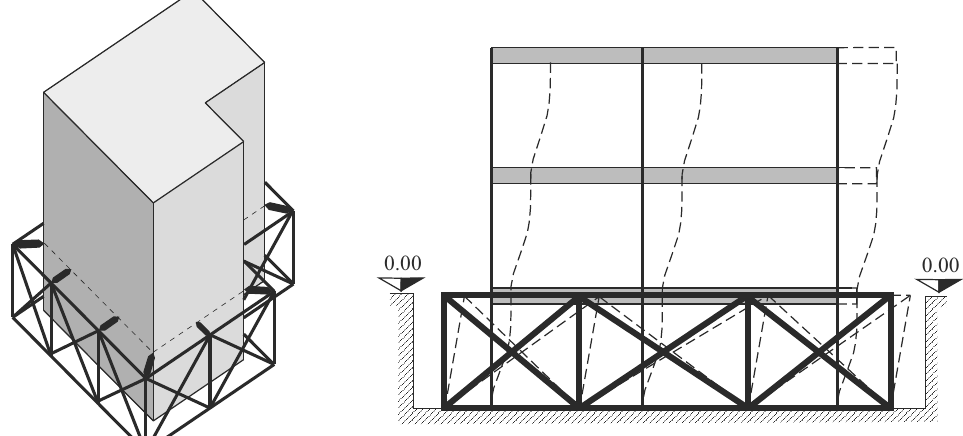
Figure 1. Indicative scheme of the connection between frame structure and